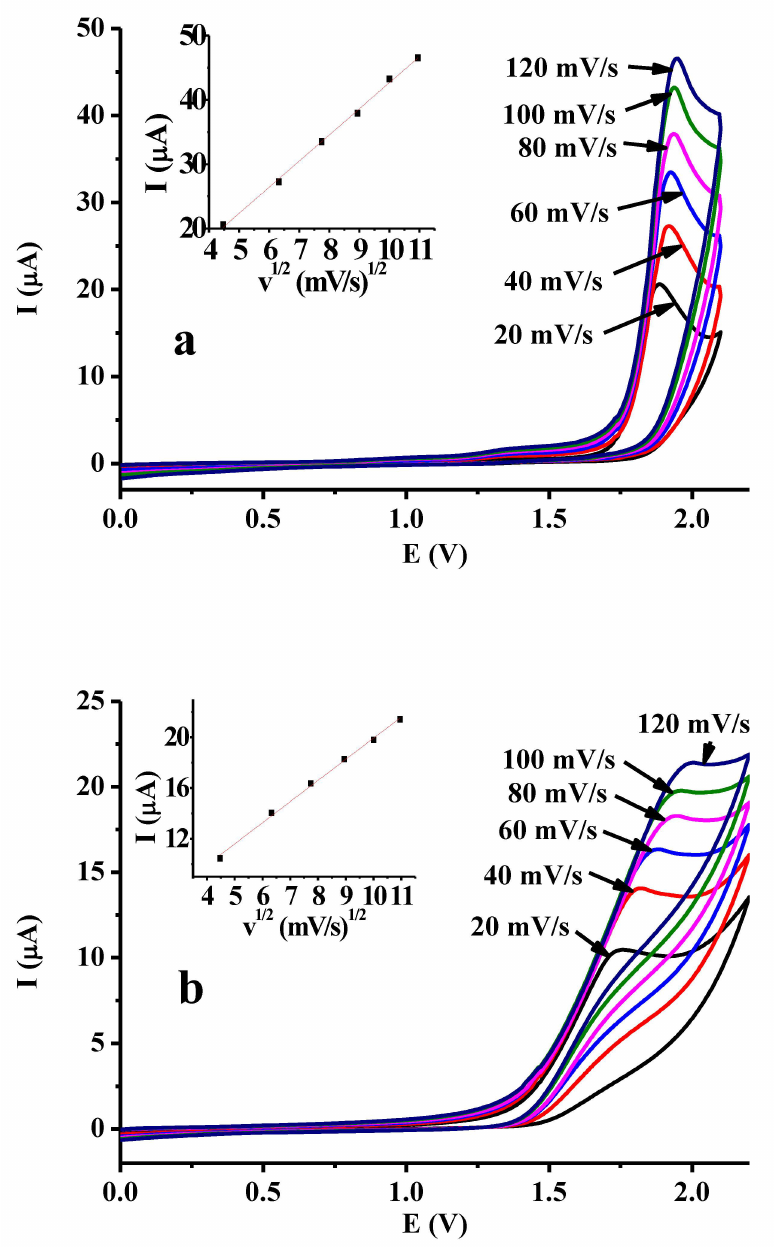
Figure 2. Dependence of peak currents on the square root of scan rate for 10 mM DBM in acetonitrile ( a ) and in 1-propanol ( b ) (scan rate 0.1 V/s, supporting electrolyte 0.05 M